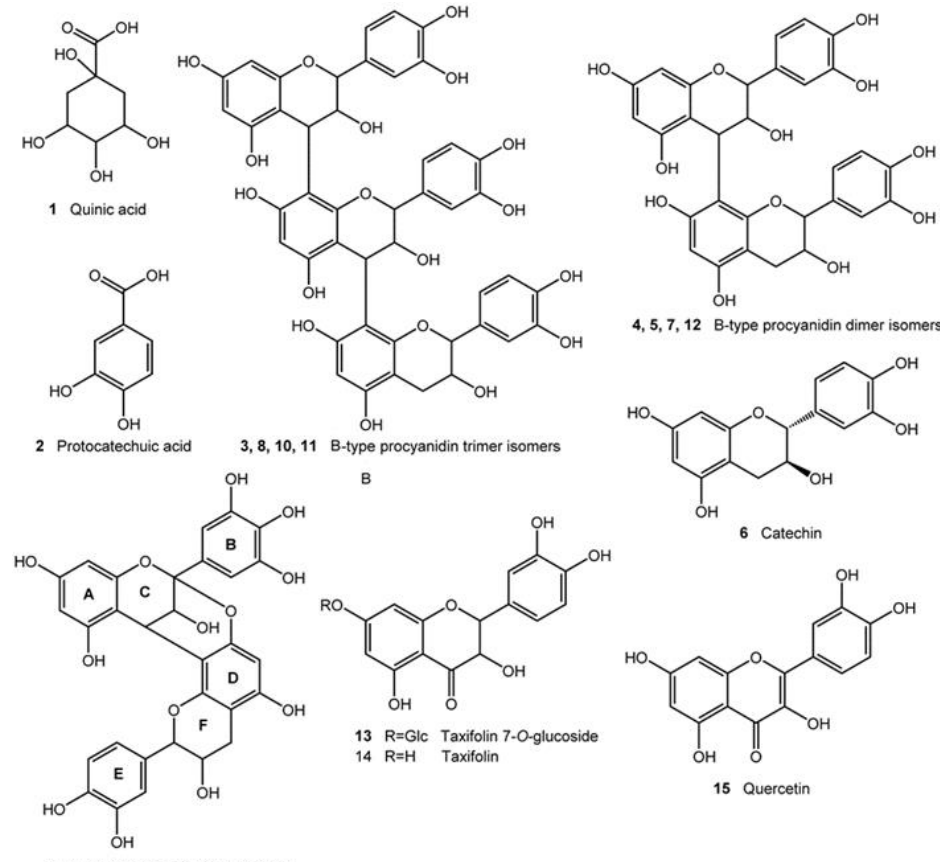
Figure 1. Chemical structures of the compounds identified in Pinus pinaster Ait. and Pinus pinea L. bark polar extracts.